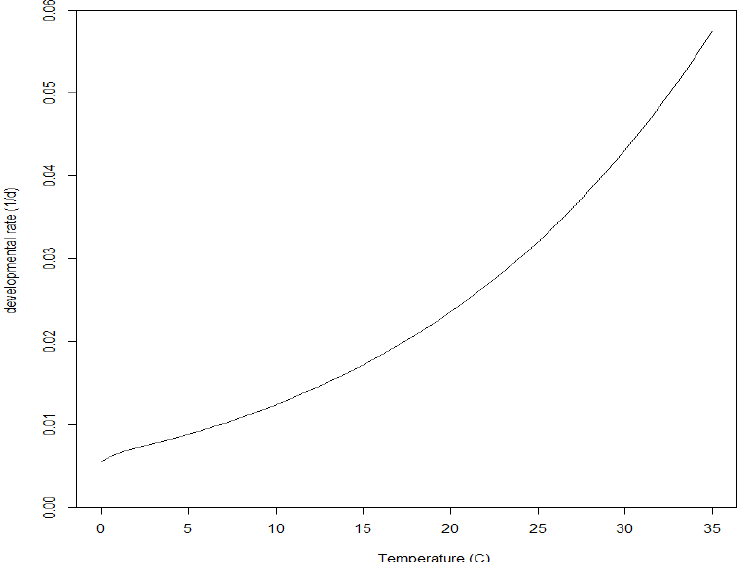
Figure 2. Developmental rate ( r ) vs. temperature ( T ) in the “reduced Sharpe-Schoolfield” model (Equation (5); copied from Salis et al. [10]). r ( T ) = T ref = 286.95 ◦ K, H A = 42.1 × 10 3 J mol − 1 , H L = 1216 × 10 3 J mol − 1 , T L = 272.15 ◦ K, and R is the universal gas constant (8.314 J ◦ K − 1 mol − 1